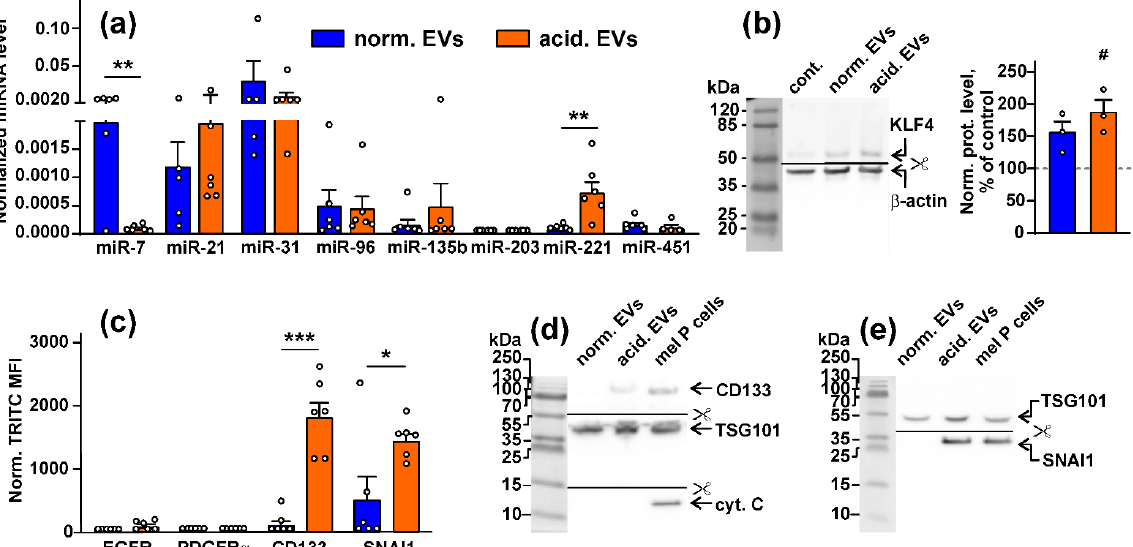
Figure 1. Analysis of the composition of EVs derived from the mel P cells cultivated at pH 6.5 (“acidified”) and pH 7.4 (“normal”): ( a ) expression of different miRNA in “normal” and “acidified” EVs was assayed by real-time PCR with stem-loop primers and normalized to the U6 non-coding RNA. Data presented as the relative miRNA level ± SEM ( n = 6). ** ( p < 0.01) indicates significant difference between the data groups according to the two-tailed t -test; ( b ) influence of “normal” and “acidified” EVs on expression of KLF4 (miR-7 target) in the Het-1A keratinocytes. Representative Western blot image of KLF4 stained by the specific antibodies in the keratinocytes and the normalized KLF expression level are shown on the left and right panels, respectively. Data presented as a ratio of the KLF expression to the β -actin expression, normalized to the same in the untreated cells ± SEM ( n = 3). # ( p < 0.05) indicates significant difference between the treated and untreated cells (control, shown by dashed line) according to the one-sample t -test. Whole Western blotting membranes are presented in Figure S9; ( c ) analysis of the EGFR, PDGFRα, CD133 , and SNAI1 expression in “normal” and “acidified” EVs by flow cytometry. Data presented as normalized MFI ± SEM ( n = 6). * ( p < 0.05) and *** ( p < 0.001) indicate significant differences between the data groups by the two-tailed t -test; ( d , e ) analysis of the CD133, SNAI1, TSG101, and cytochrome C expression in EVs by Western blotting. Whole Western blotting membranes are presented in Figure S9.